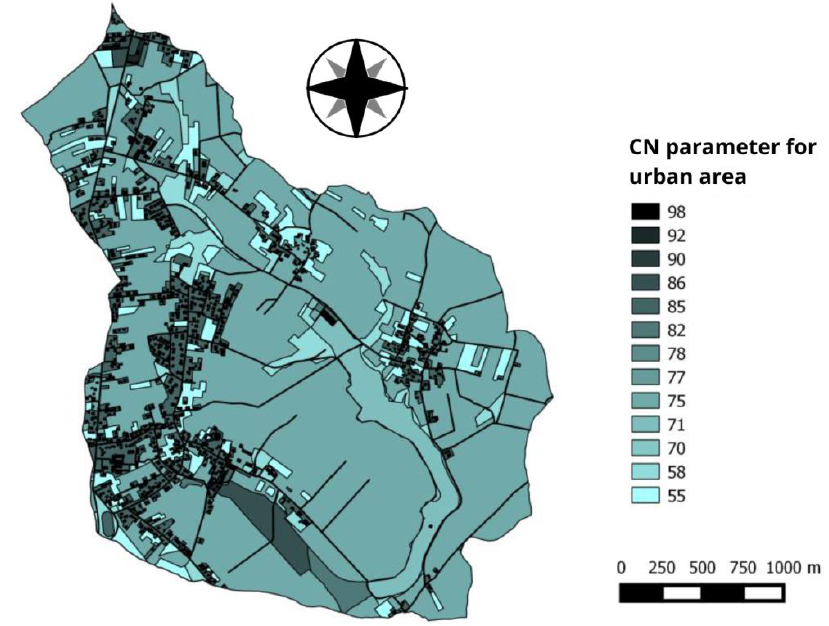
Figure 3. Curve number for urban area.